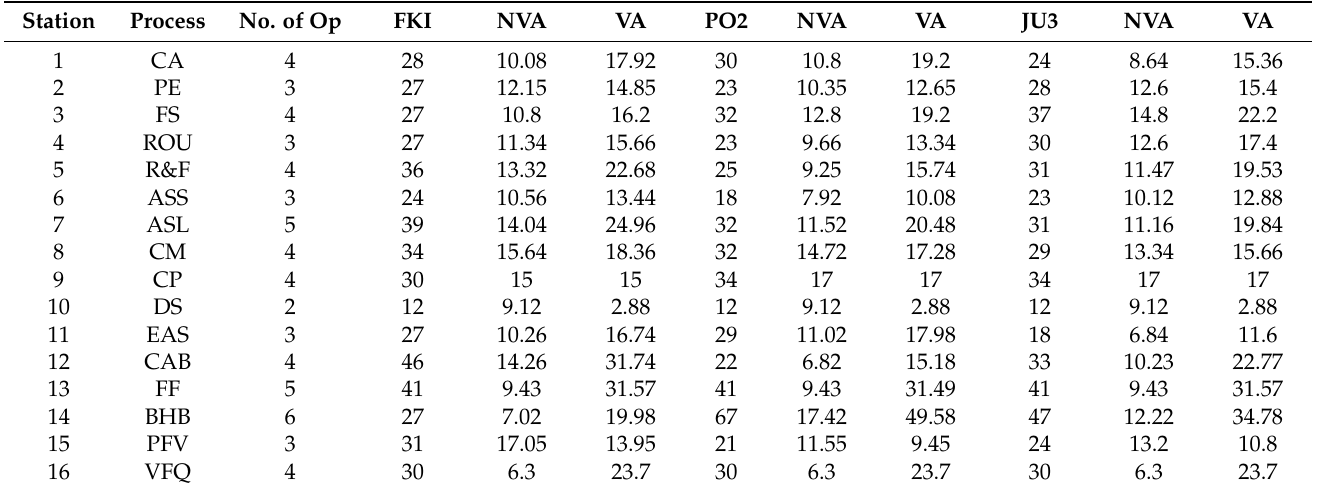
Table 1. The truck manufacturing assembly’s current state is plotted to visualize the current situation.